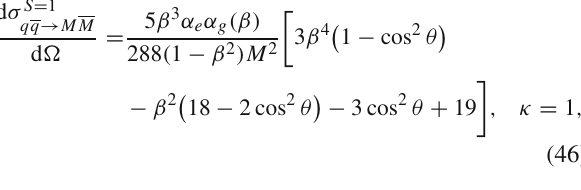
cross section diverges as ∼ M − 2 for κ = 0 and more rapidly as ∼ M − 4 for other κ